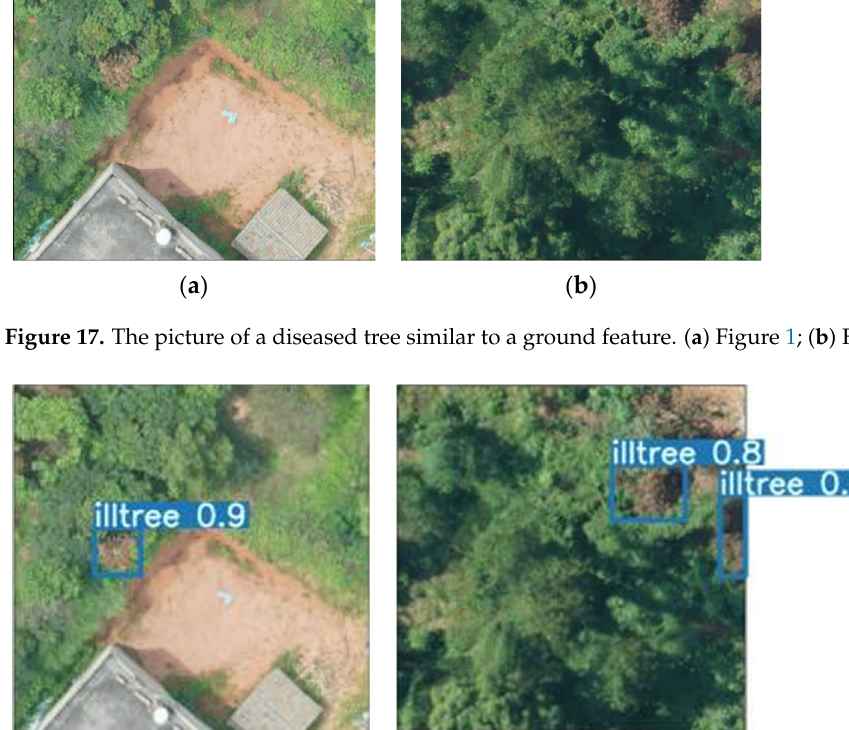
Figure 17. The picture of a diseased tree similar to a ground feature. ( a ) Figure 1; ( b ) Figure 2.